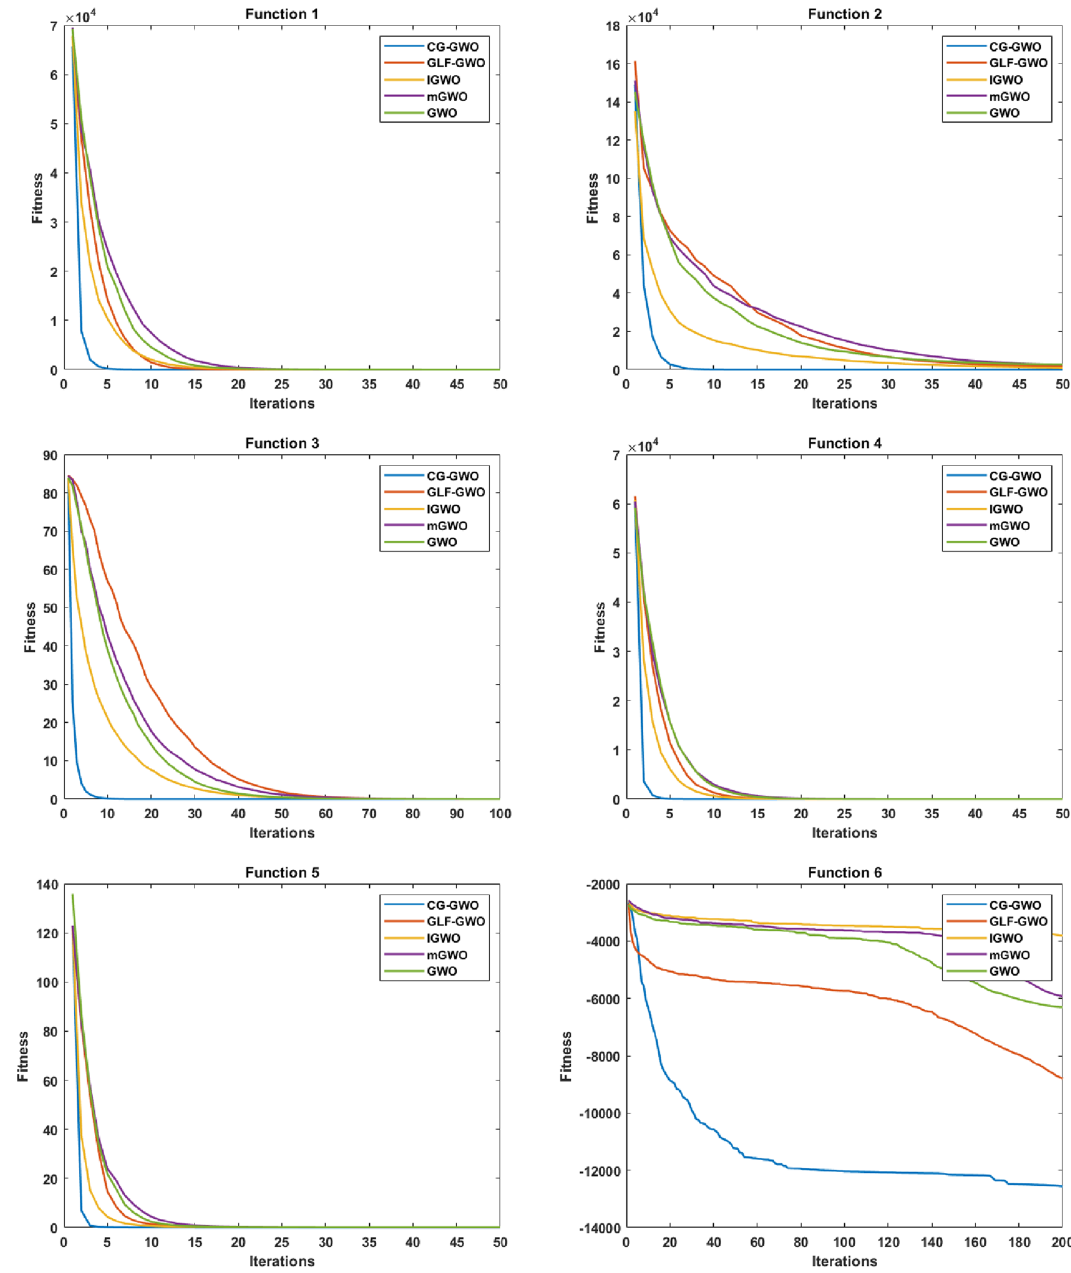
Figure 6. Convergence curve comparison of improved GWO